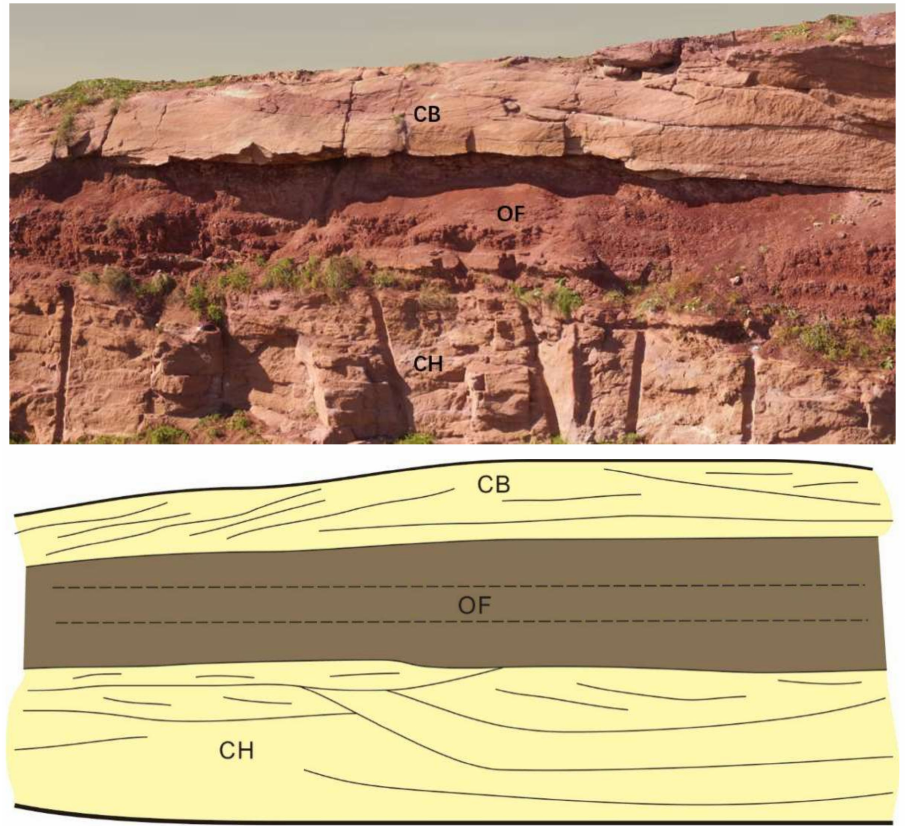
Figure 7. Typical bank overflow deposits in the outcrop section of the Yungang Formation. The grain size is mudstone and siltstone. Occurs on channel